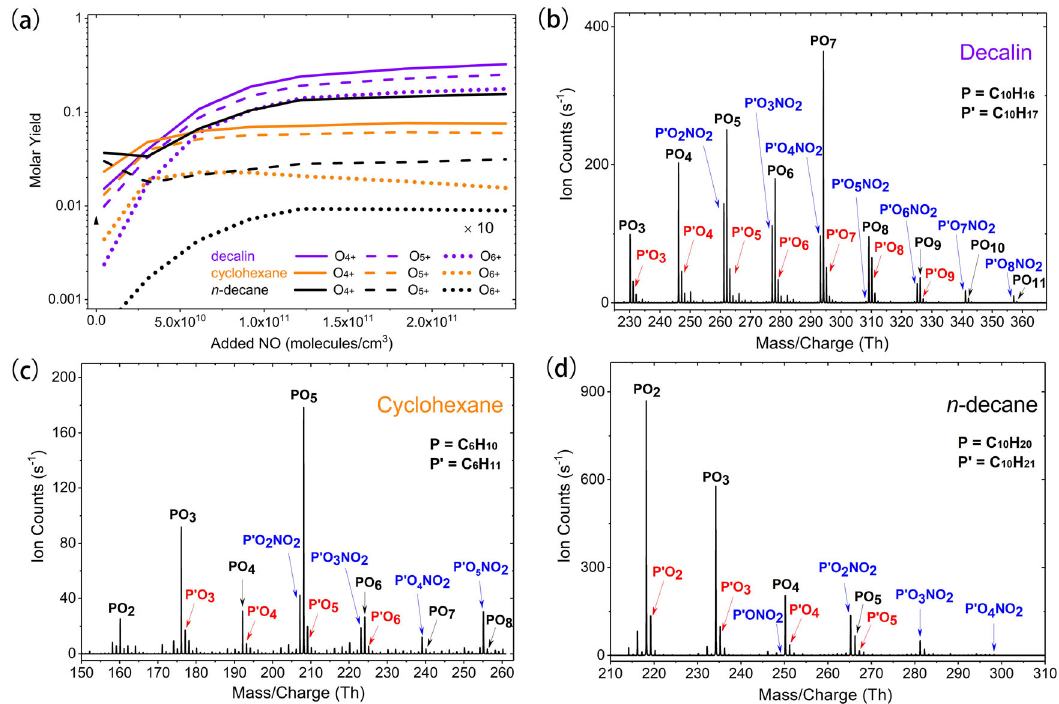
Fig. 4 Effects of NO on product distributions from OH oxidation of decalin, cyclohexane and n -decane in the Leipzig fl ow reactor. a The experimentally measured molar yields of products with at least 4, 5, or 6 O-atoms, respectively, are given as different line types, while the precursor alkanes each have separate line colors. The molar yield of products with at least 6 O-atoms from n -decane oxidation is multiplied by 10 for clarity. The data points were measured at NO concentration of 4.7×10 9 , 3.1× 10 10 , 6.1× 10 10 , 9.2×10 10 , 1.2×10 11 , 1.8× 10 11 , and 2.4× 10 11 molecules/cm 3 , respectively. We note that this connection between NO and HOM yield should not be applied directly to the atmosphere, as the exact relations depend strongly on experimental conditions. The mass spectra, measured as adducts with ethylaminium, at the highest NO addition of 2.4×10 11 moleculescm − 3 are plotted separately for b decalin, c cyclohexane, and d n -decane. In each spectrum, radicals are in red, nitrates in blue, and other closed shell compounds, mainly carbonyls, in